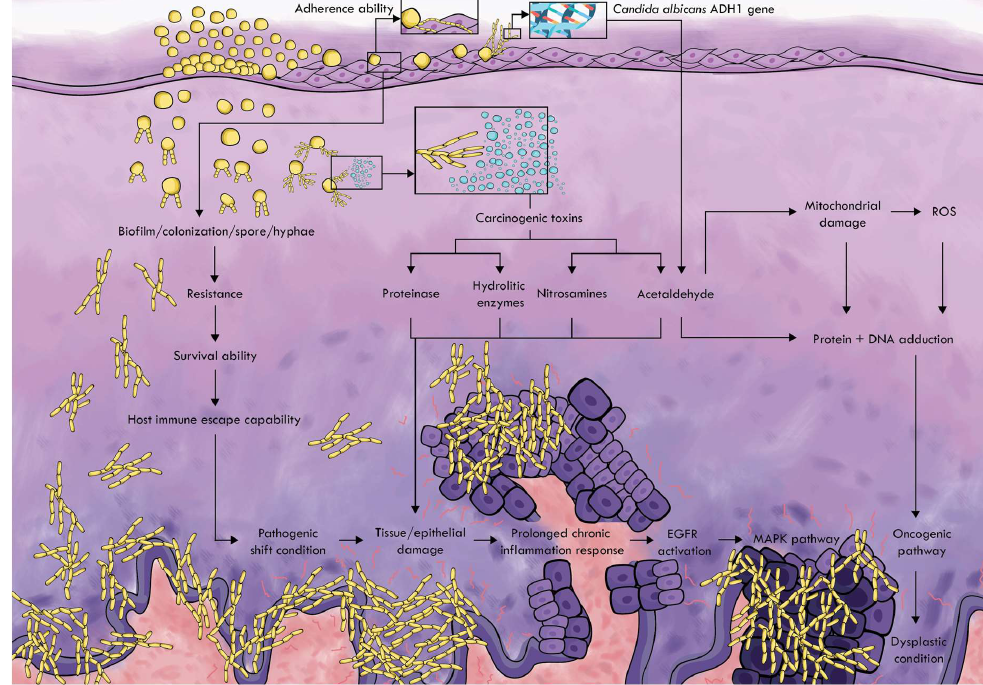
Figure 1. Candida albicans carcinogenic